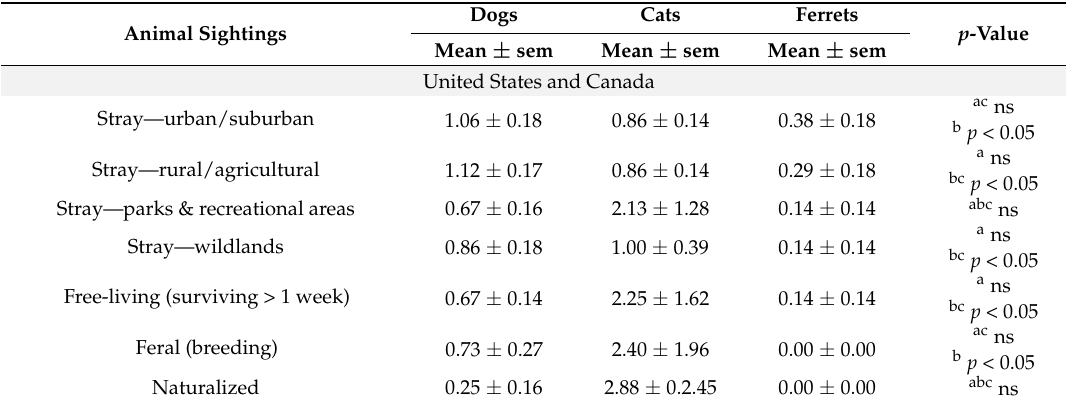
Figure 2. Average number of animals per sighting of ( A ) United States, Canada, and ( B ) California counties. Rating mean ± standard error of the mean (sem). Asterisk represents significant difference; * p < 0.05, ** p < 0.01. Table 1. Number of animals per sighting.